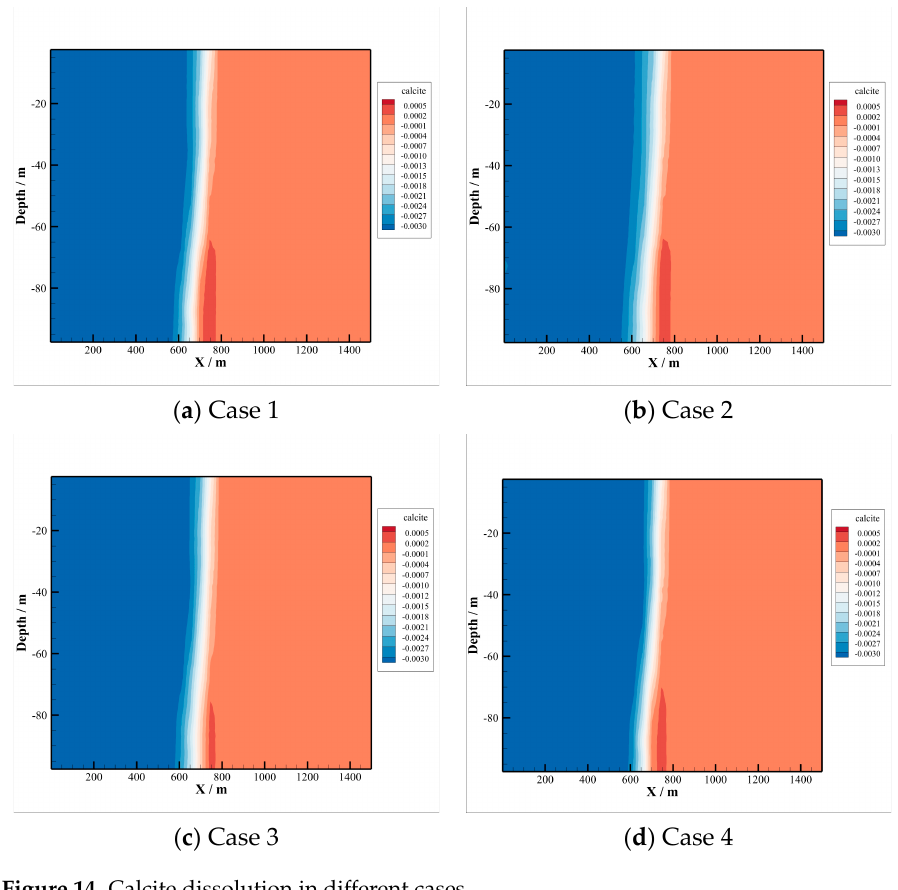
Figure 14. Calcite dissolution in different cases.